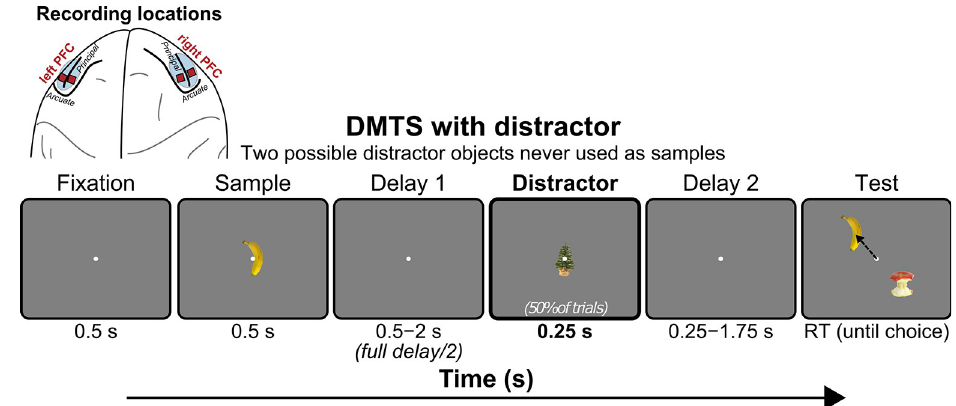
Fig 1. Electrode location and task structure. Utah arrays were implanted bilaterally in dorsolateral PFC (dlPFC) and ventrolateral PFC (vlPFC). Animal performed a distracted delayed match-to-sample task. Each trial began with visual fixation on the middle of the screen for 0.5s. Fixation was maintained throughout the trial until the behavioral response. The delay length was parametrically varied from 1–4 s in five logarithmic steps, randomly chosen each trial. At mid-delay a neutral distractor (1 of 2 possible objects never used as samples) was presented randomly on 50% of trials. During the multi-choice test the NHP was allowed to freely saccade between all objects on the screen. The final choice was indicated by fixating on it for at least one